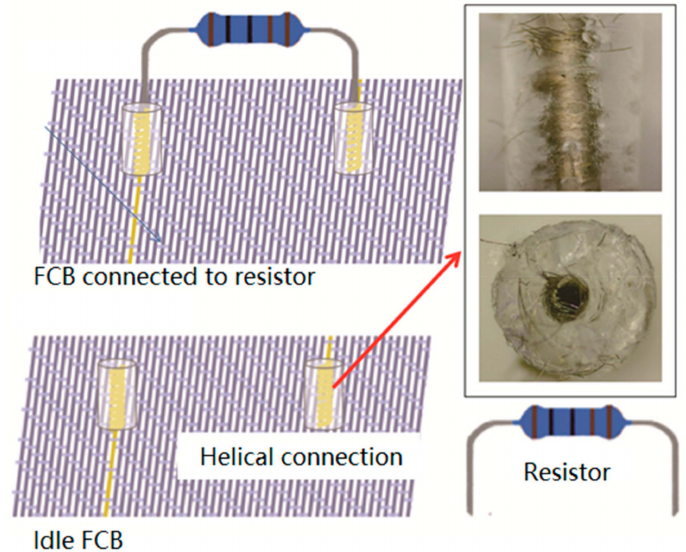
Figure 7. Helical connections between the conductive track and the resistor electrode.